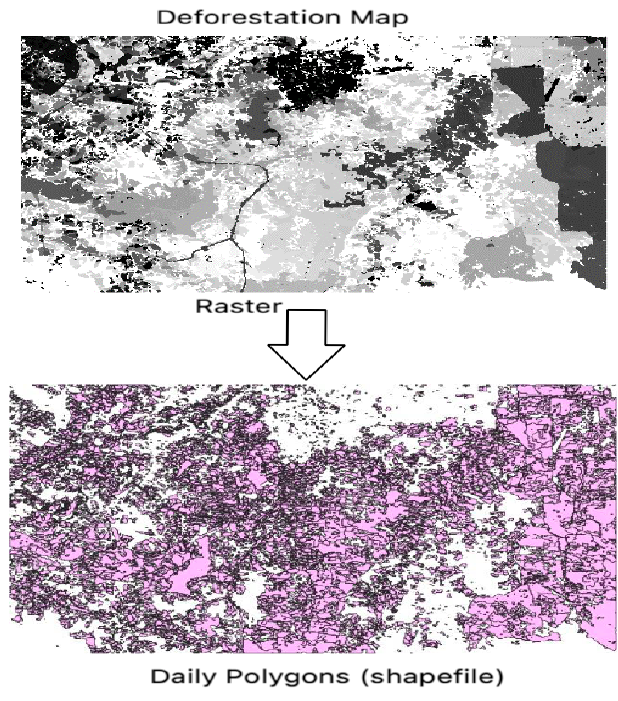
Figure 6. Creating daily polygons.